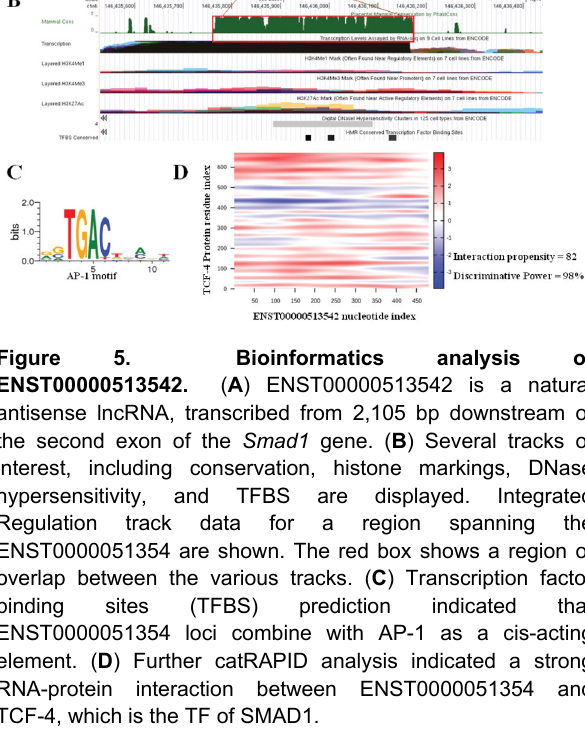
RP11-473L15.2 is a bidirectional lncRNA, 49 bp from the transcription start site of FGF10 (Figure S1 A). As for Figure 5, we identified a region of overlap between the various tracks in the RP11-473L15.2 loci (Figure S1 B). Prediction of TFBS indicated that RP11-473L15.2 combines with the SRF (serum response factor) motif (Figure S1 C). However, no intense RNA-protein interactions were identified between